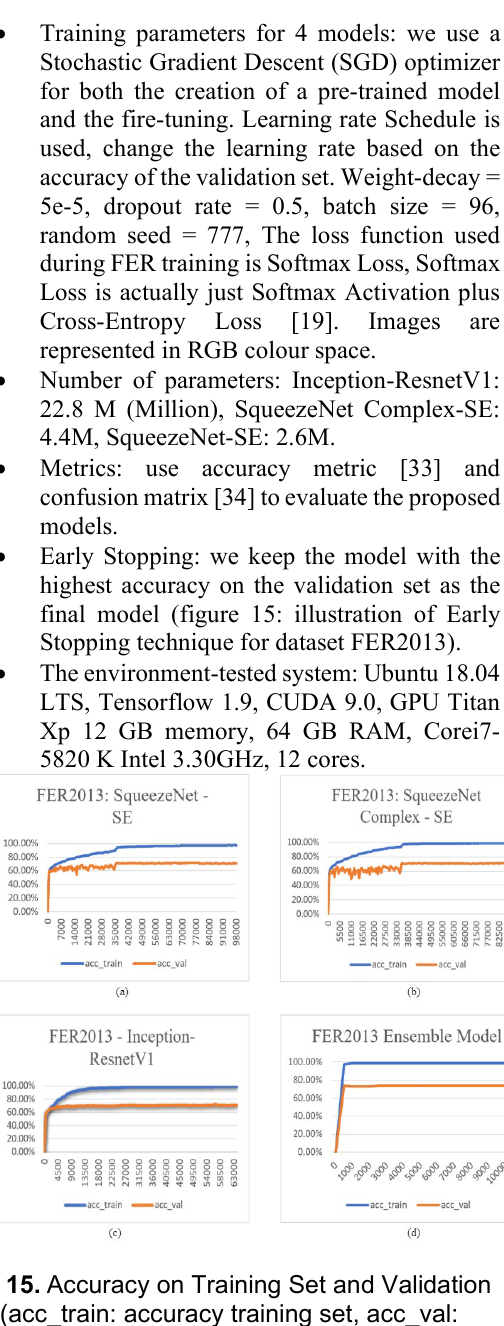
Table 1. Accuracy (%) per expression on dataset Model